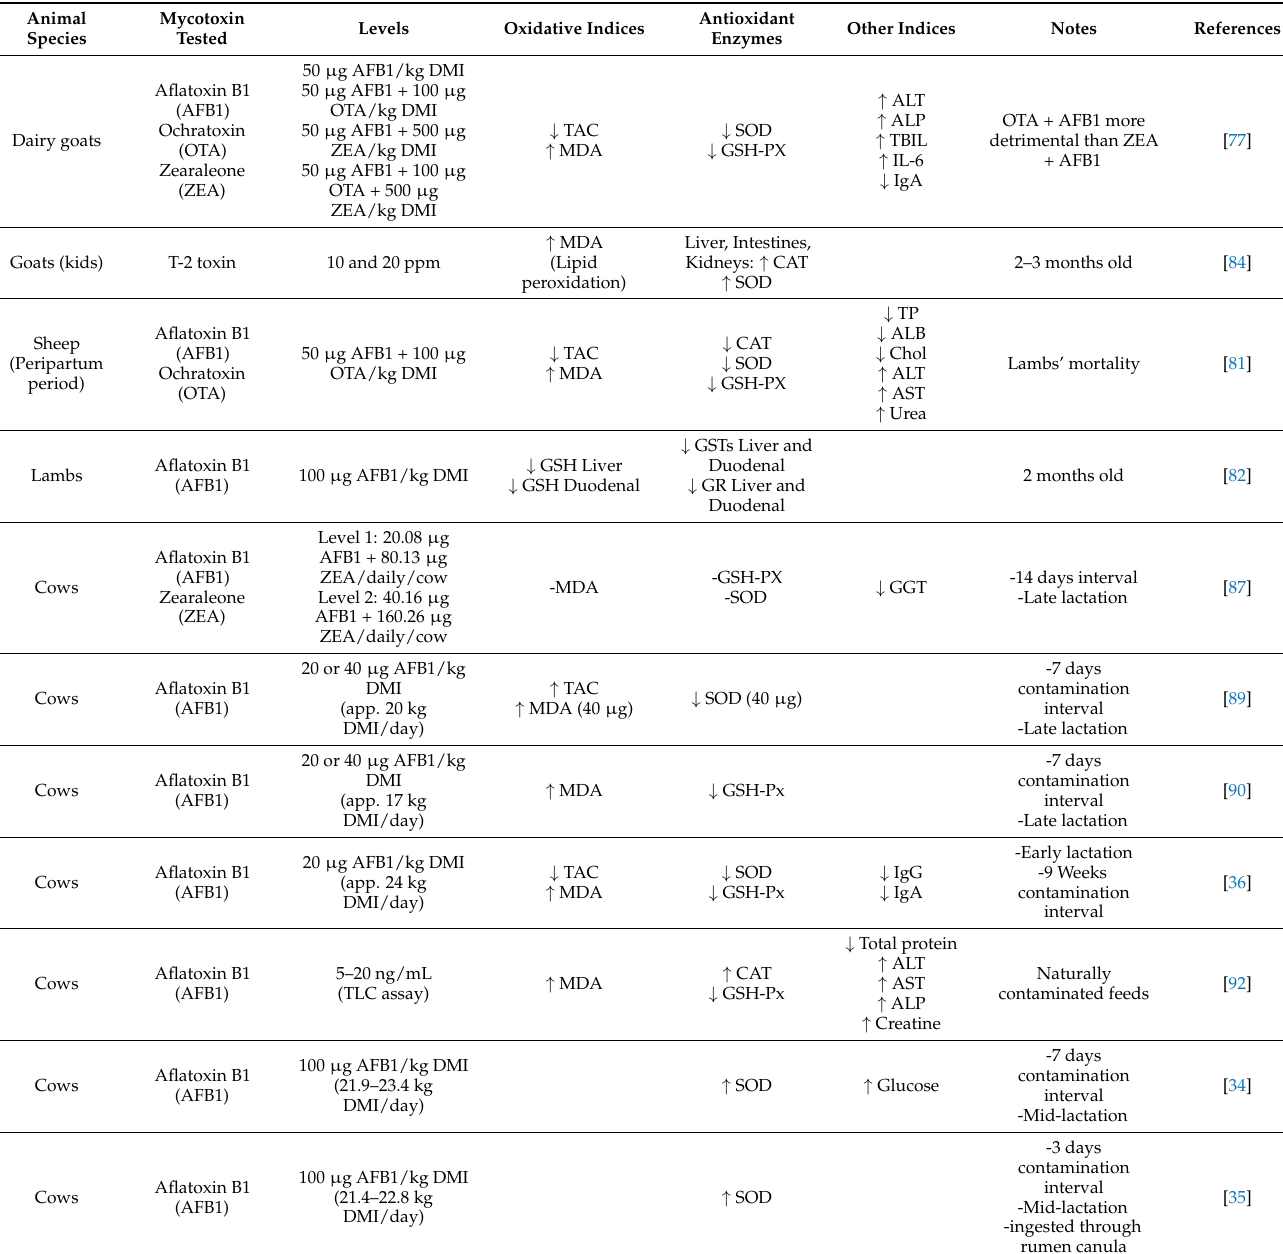
Table 4. Selected studies presenting the effects of mycotoxins on the ruminants’ oxidative indices, antioxidant enzymes, and cellular